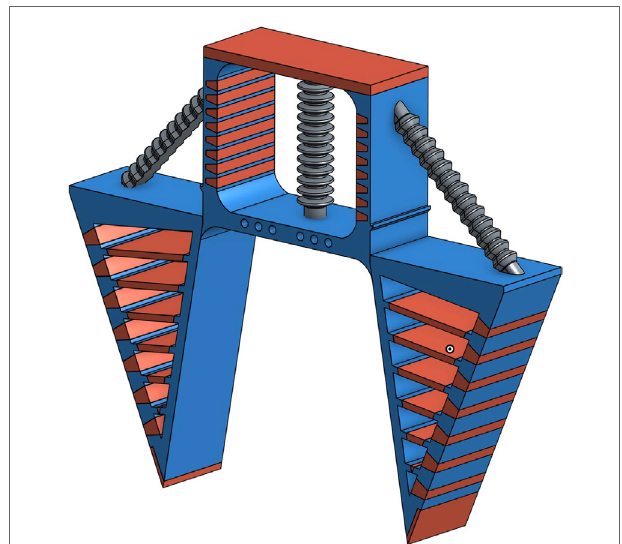
FigUre 8 | The pneumatic version of the Tihra gripper